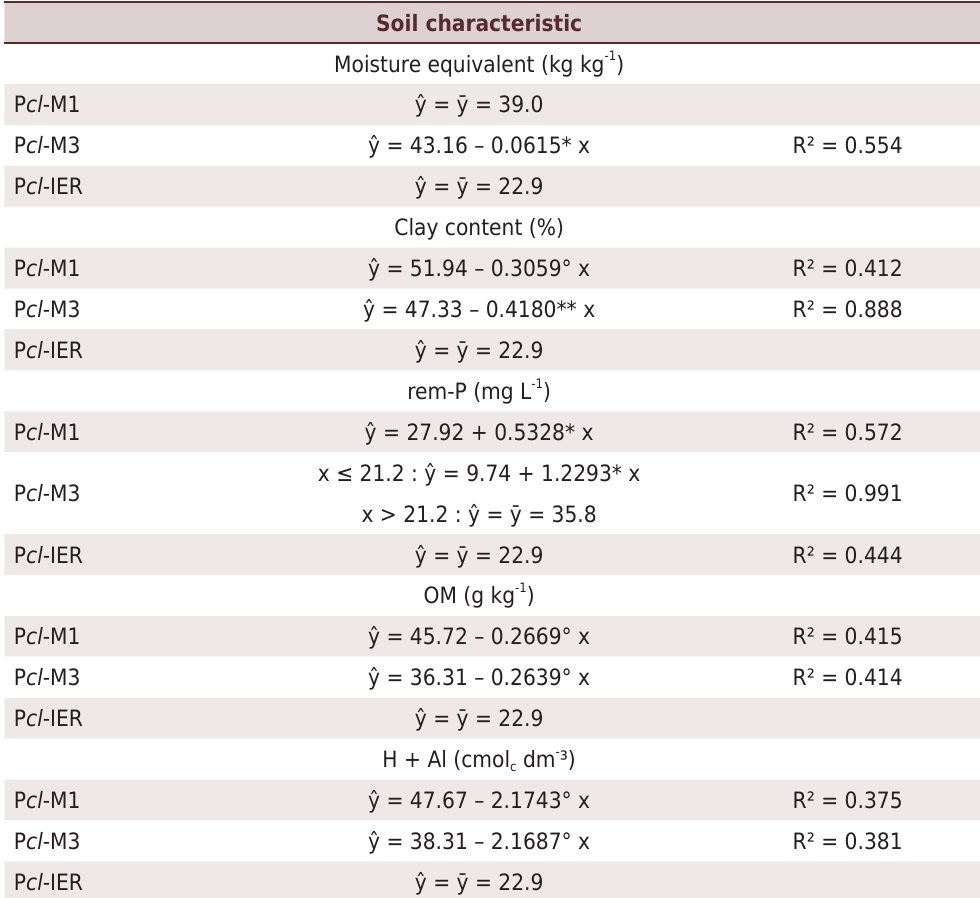
Table 6. Equations of soil P critical level by Mehlich-1 (P cl -M1), Mehlich-3 (P cl -M3), and Ion Exchange Resin (P cl -IER) according to soil characteristics related to soil P buffering capacity: moisture equivalent, clay content, remaining P (rem-P), soil organic matter (OM), and potential acidity (H + Al)